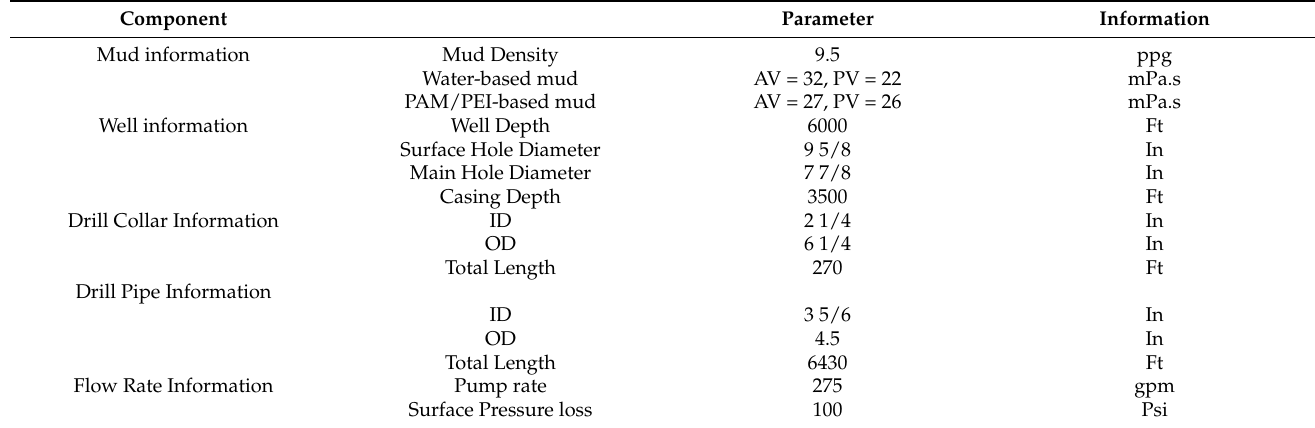
Table 4. Mud and well information used for the hydraulic calculations.